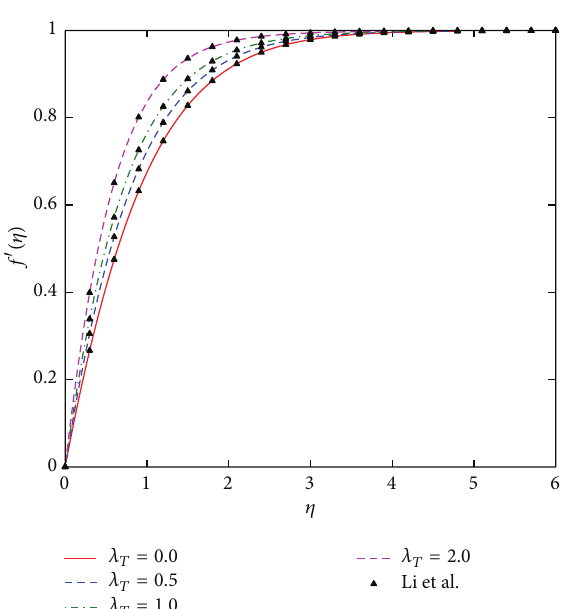
Figure 3: Verification of the results 𝑓 󸀠 (𝜂) with the previously published paper by Li et al. when 𝑘 1 = 0.3 , 𝑚 = 1.0 , and Pr = 1.0 .